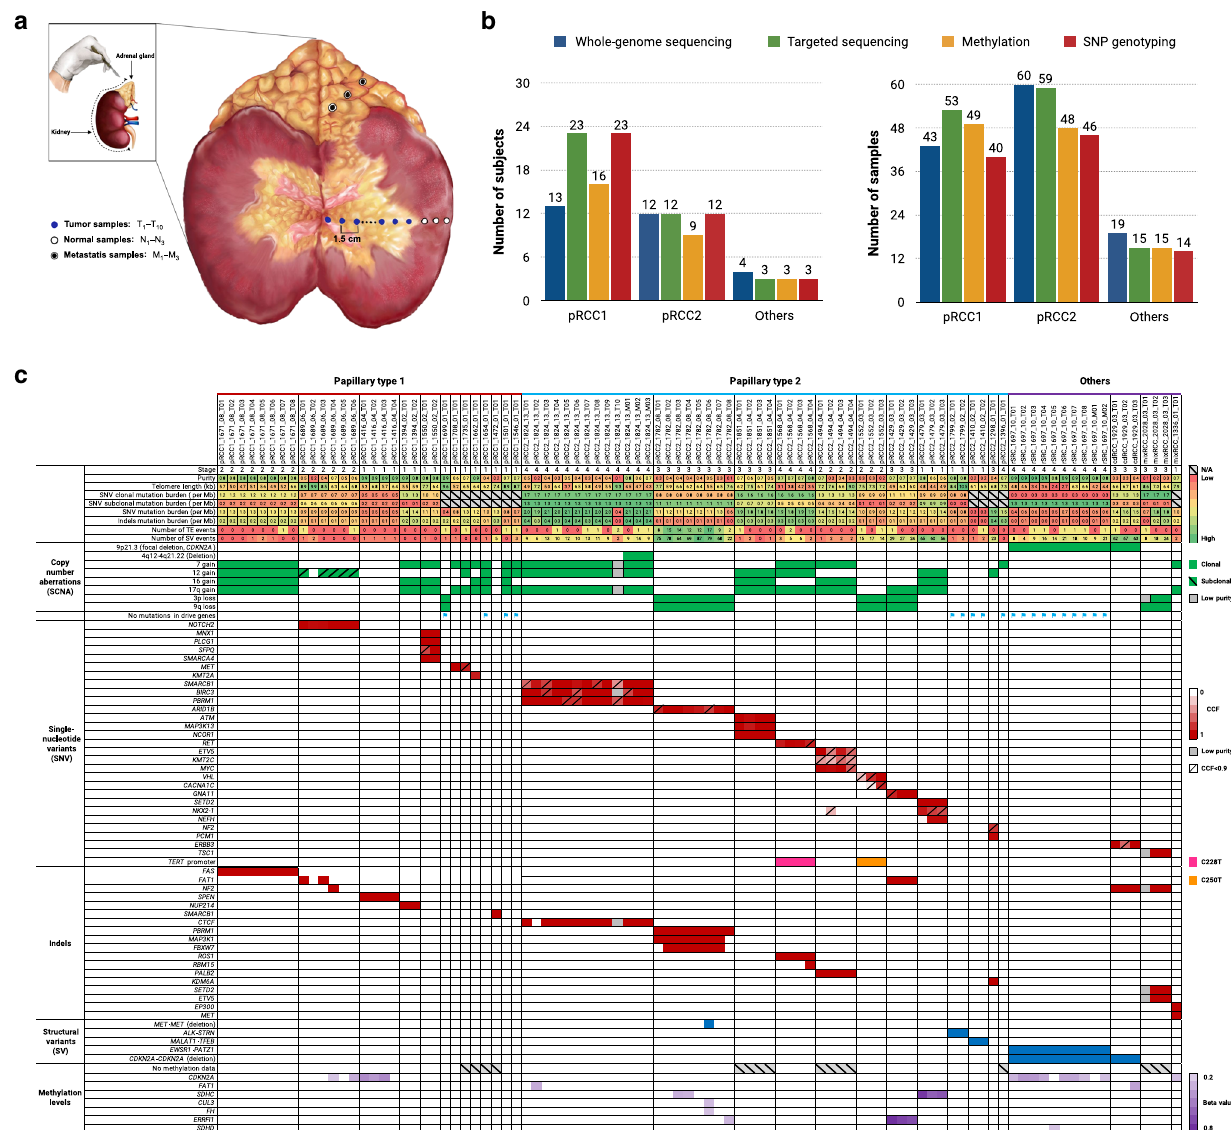
Fig. 1 Study design and genomic landscape. a A schematic illustration of the dissection of multiple tumor samples from the center of the tumor towards the tumor ’ s periphery, plus metastatic samples in the adrenal gland as well as normal samples. For the analysis, the normal sample more distant from the tumor and with absence of tumor nuclei was chosen as reference. b Summary of subjects and samples that underwent different analyses based on DNA availability: whole-genome sequencing (124 samples from 29 subjects), deep targeted sequencing of cancer driver genes (139 samples from 38 subjects), genome-wide methylation (139 samples from 28 subjects) or SNP array pro fi ling (only tumor samples, 101 samples from 38 subjects). c Tumor genomic alterations across histological subtypes. Shown are genome level changes, such as mutational burden, numbers of structural variants (SV) and retrotransposition events (TE), as well as other genomic alterations (denoted by different